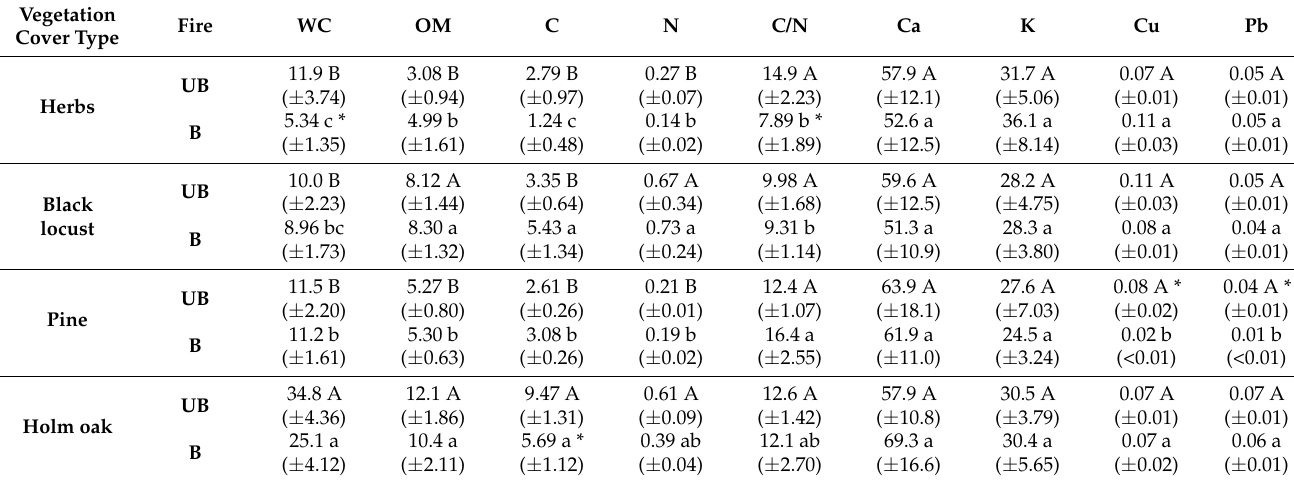
Table 2. Mean values ( ± st. err.) of water (WC, expresses as % d.w.) and organic matter contents (OM, expresses as % d.w.), C and N concentrations (expressed as % d.w.), C/N ratios, total concentrations of Ca, K, Cu and Pb (expressed as mg g − 1 d.w.) measured under different vegetation cover types (herbs, Black locust, pine and Holm oak) in unburnt (UB) and burnt (B) soils collected at the Vesuvius National Park.